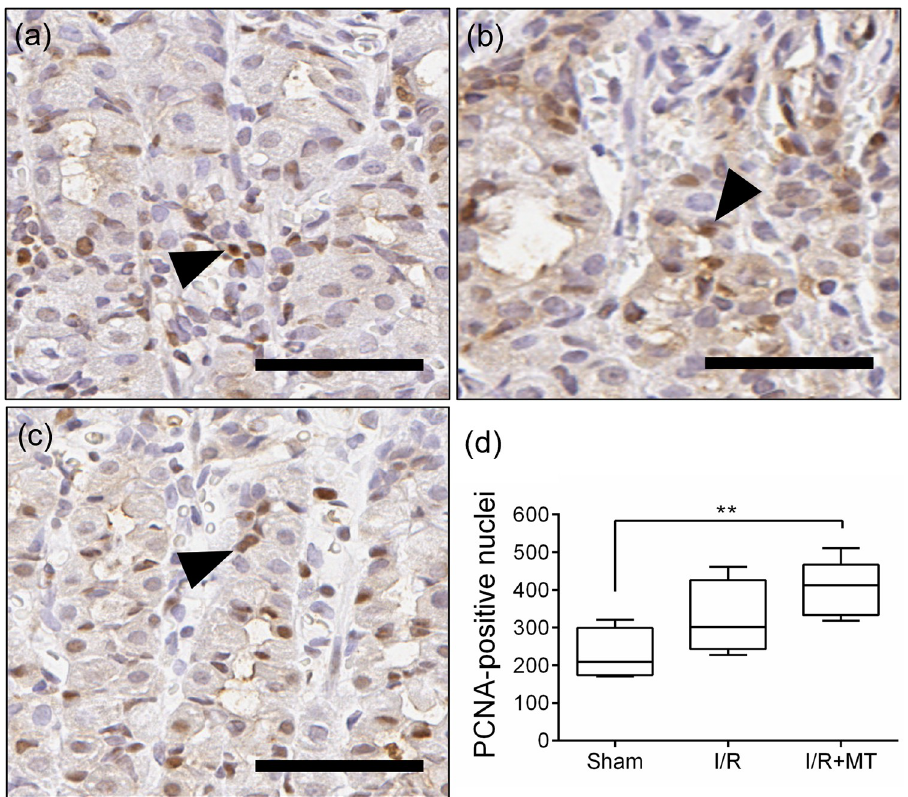
Fig 6. Effect of MT on proliferation in experimental groups. Representative photomicrographs of PCNA immunodetection (a) to (c). Identifiers: (black arrowhead) PCNA-positive nuclei. Scale bar: 100 μ m. Graphic representation of the quantification of the number of PCNA-positive (d). A Kruskal Wallis statistical test was performed followed by a Dunnett post hoc T3. The results are presented as the median and the IQR. �� p < 0.001. Treatment with MT increased proliferation in glandular epithelium cells in the I/R